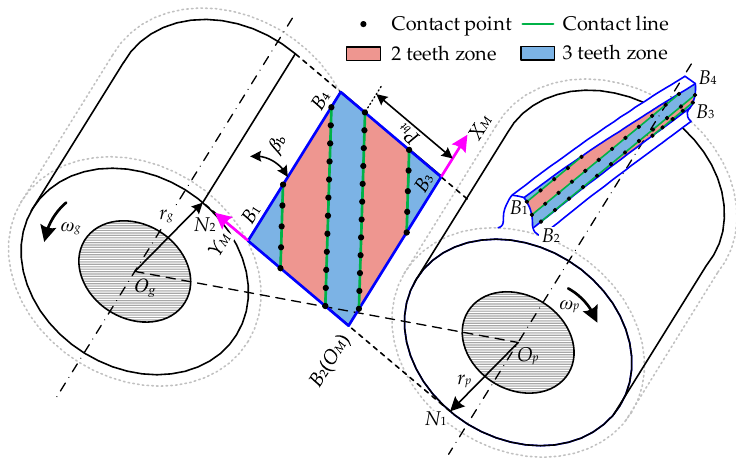
Figure 3. Enhanced loaded tooth contact analysis (LTCA) model of a helical gear pair during one mesh cycle.